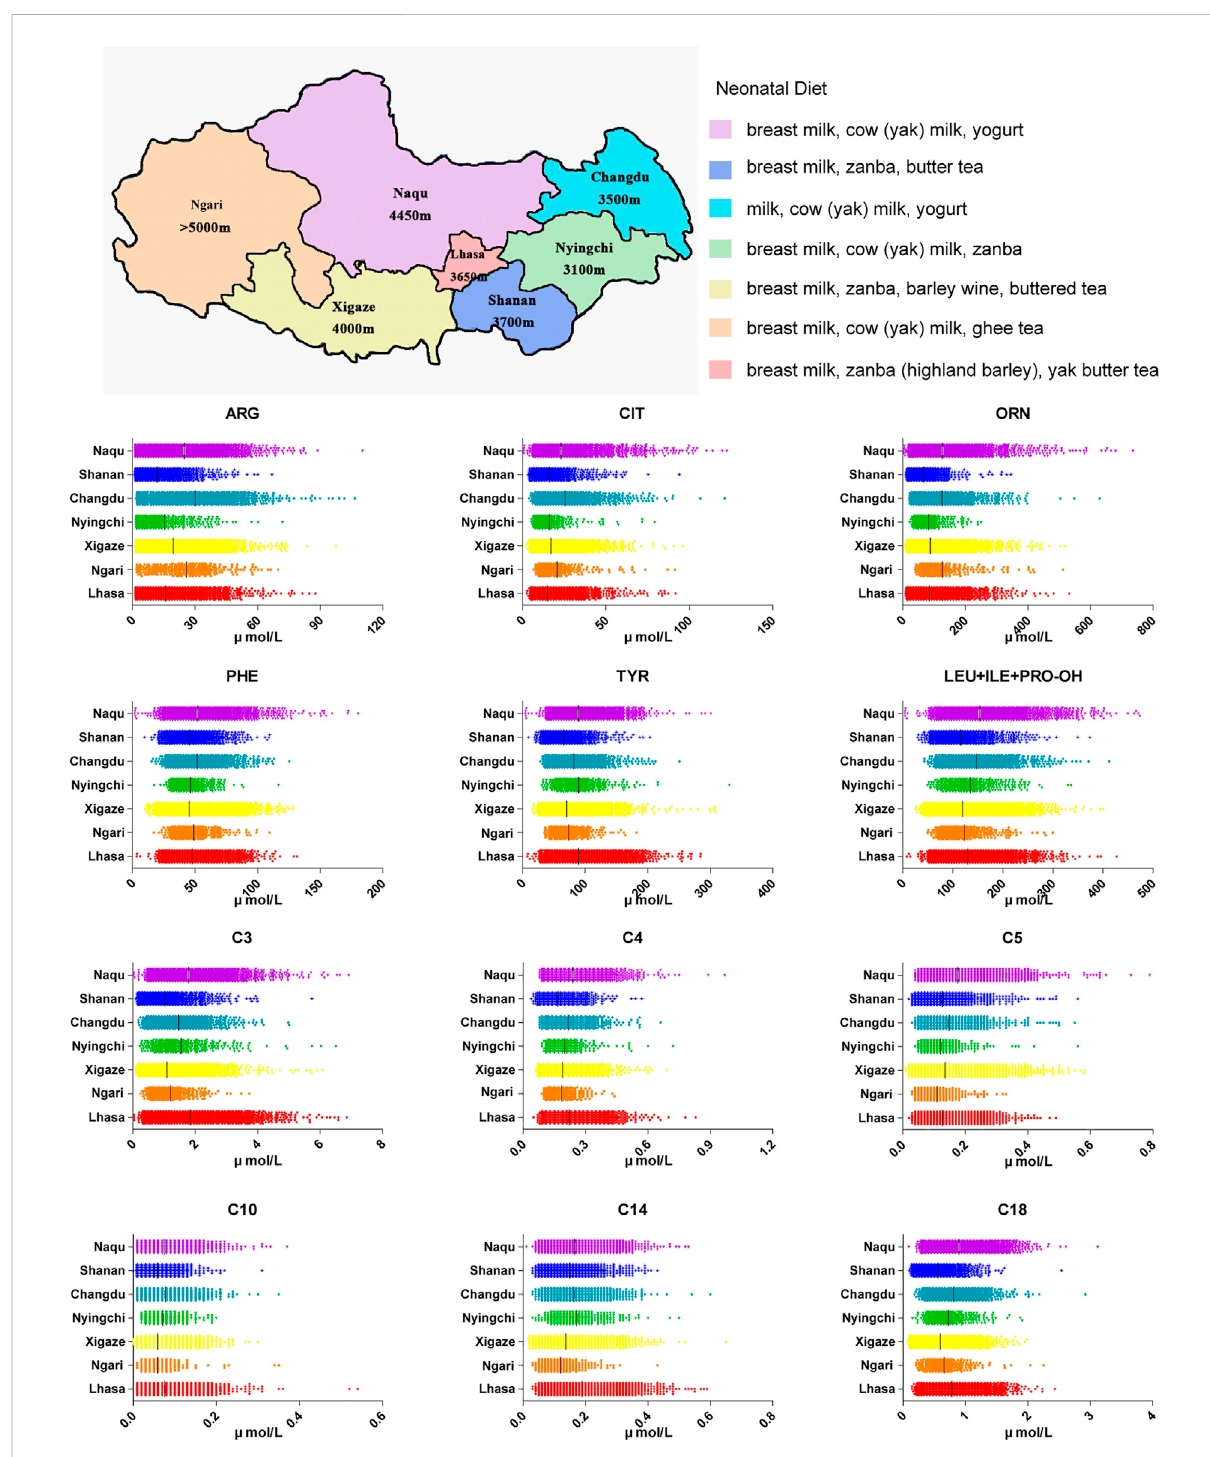
FIGURE 2 Neonatal diet in Tibet Autonomous Region as well as amino acids and acylcarnitine in different areas of